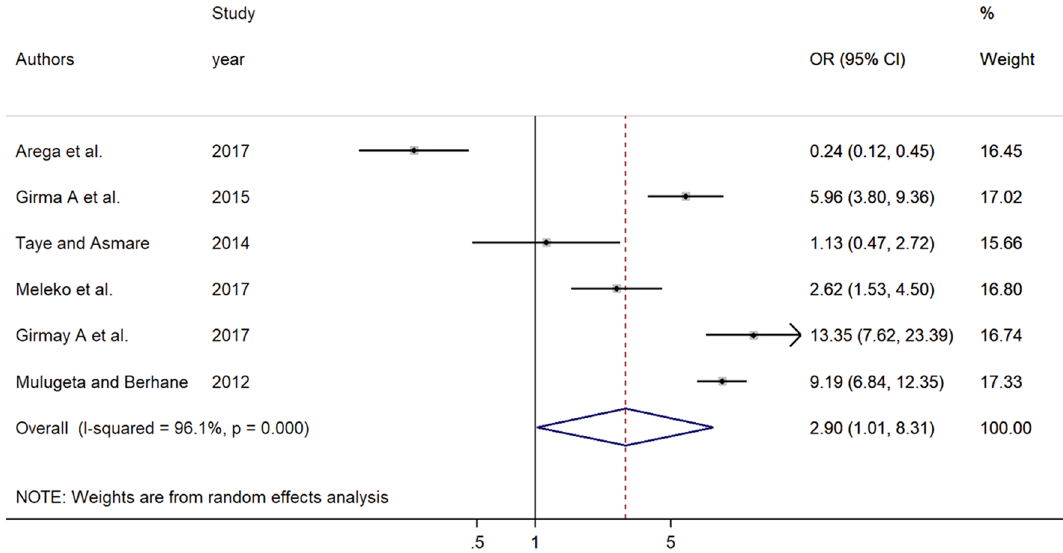
Figure 4. Forest plot of the association between premarital sexual practice and peer pressure among young individuals in Ethiopia,